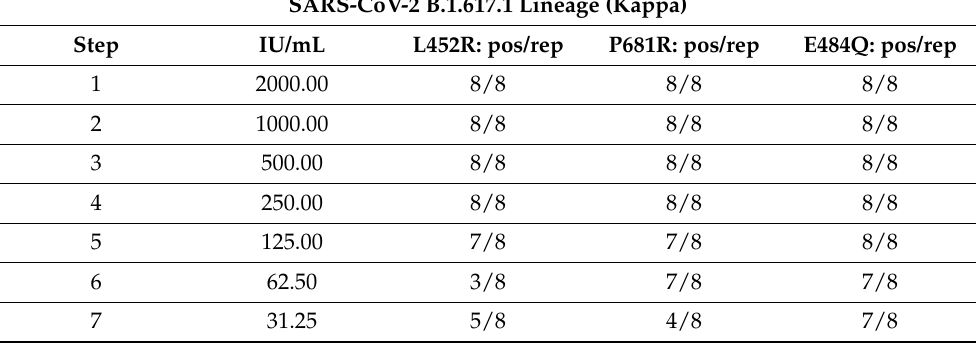
Table 3. A clinical sample containing B.1.617.1 lineage was normalized to WHO standard. A total